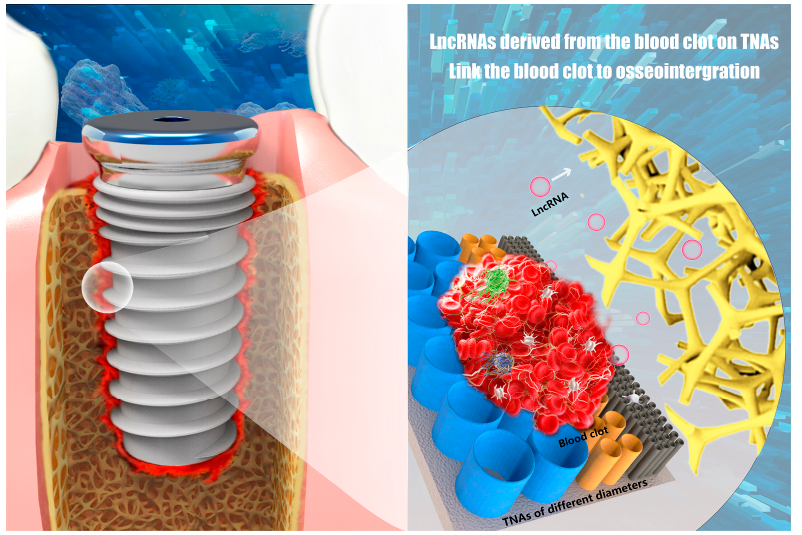
Figure 8. Illustration of the correlation between LncRNAs in the Blood Clot formed on Nano- Scaled Implant Surfaces and Osseointegration.